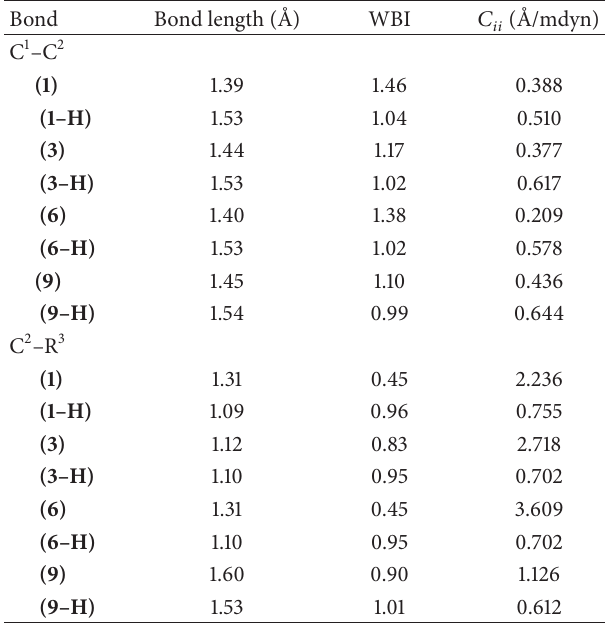
Table 3: Bond length, Wiberg’s bond index (WBI), and compliance constants ( 𝐶 𝑖𝑖 ) for multisubstituted ethyl cations 1 , 3 , 6 , and 9 and corresponding